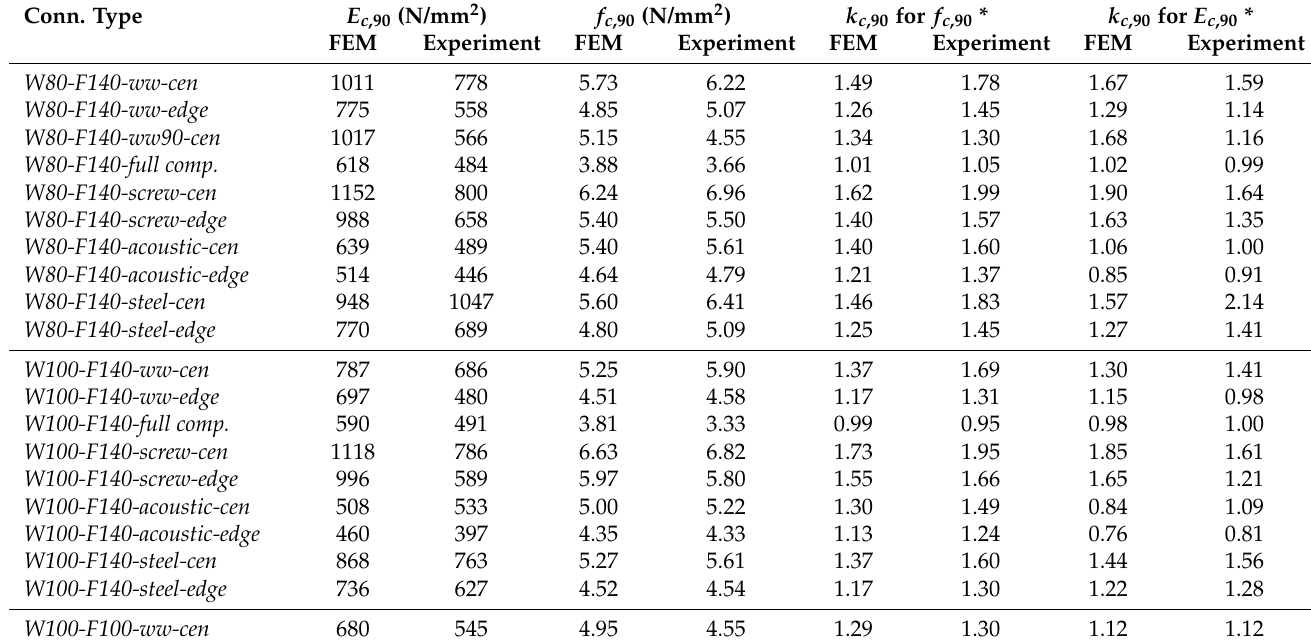
Table 5. Comparison of E c ,90 , f c ,90 , k c ,90 for f c ,90 , and k c ,90 for E c ,90 from experiments and finite element modeling. Conn. Type E c ,90 (N/mm 2 ) FEM Experiment FEM Experiment FEM Experiment FEM Experiment